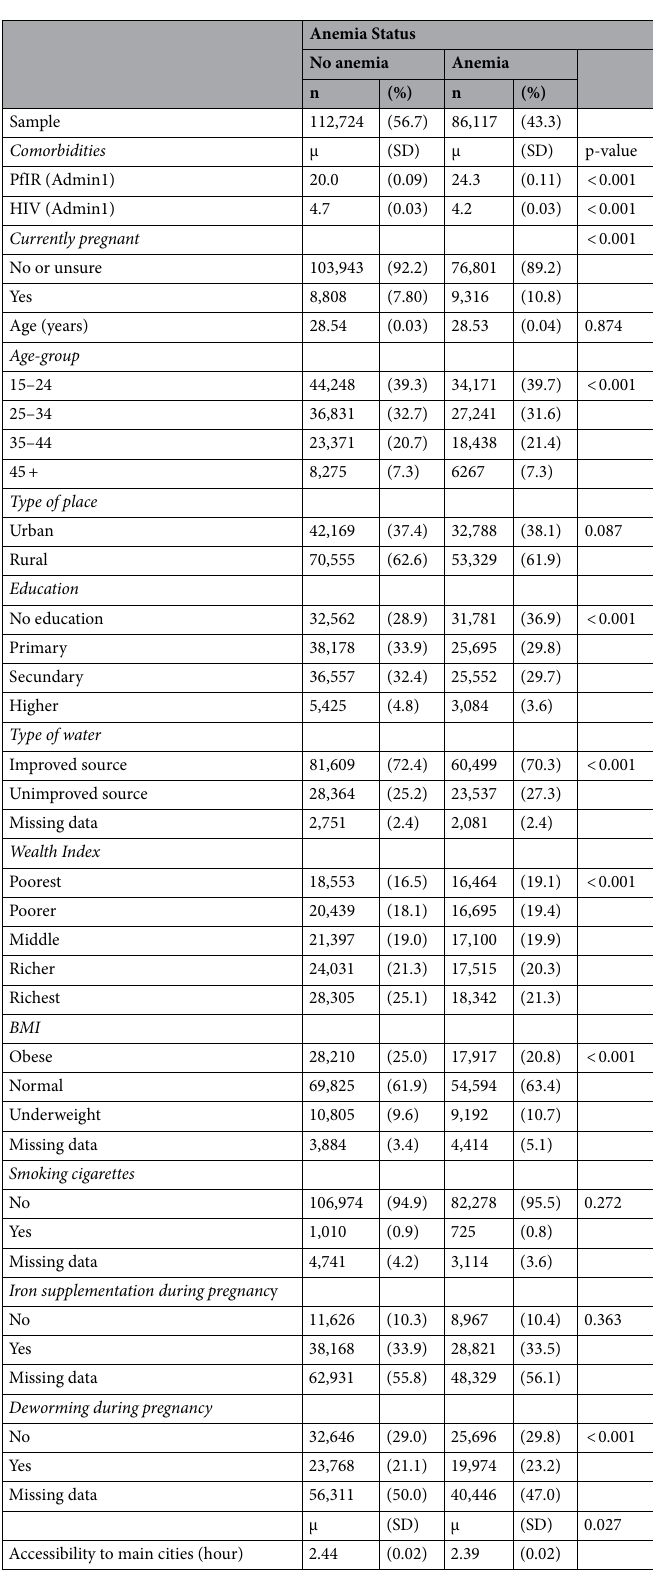
Table 1. Population characteristics by anemic status and Admin1-level